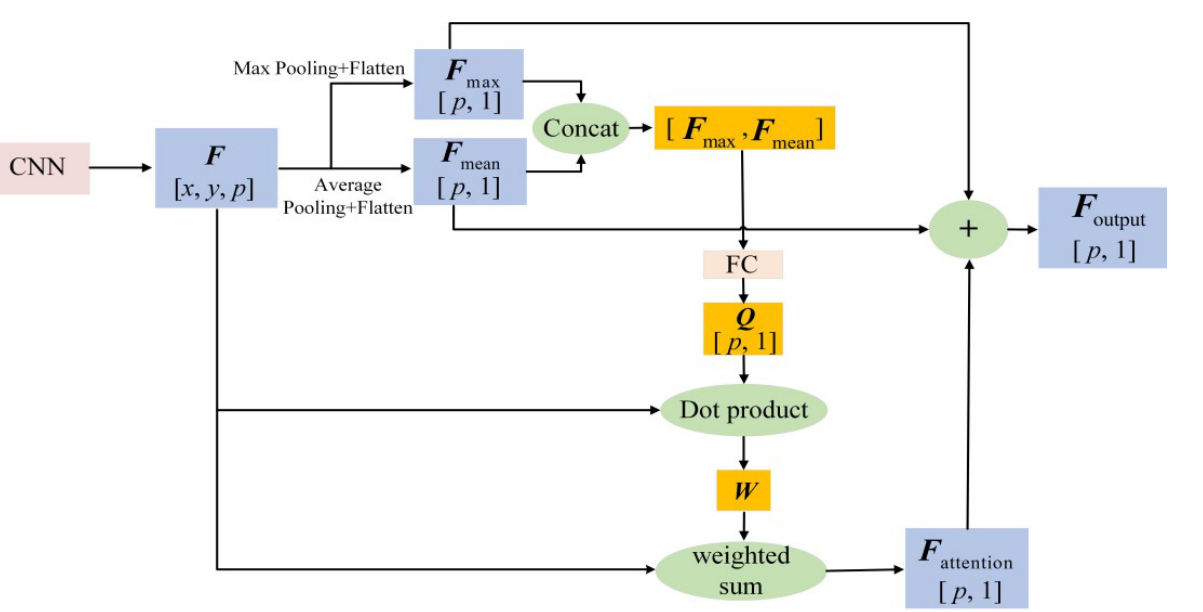
Figure 2. Improved ZSIC model.